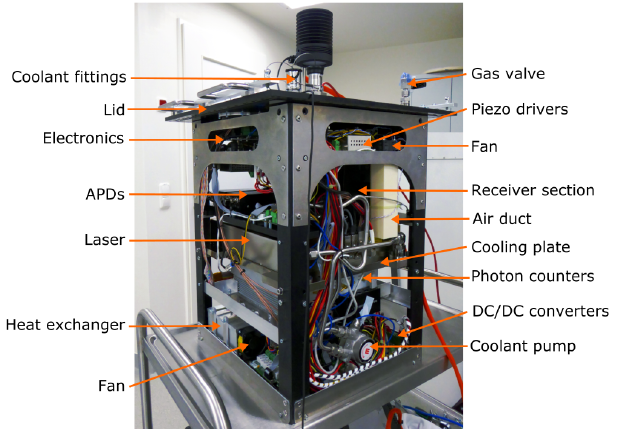
Figure 3. The pressurized section containing the lidar receiver, laser, and electronics. This picture was taken during integration with the bottom half of the pressure vessel removed.